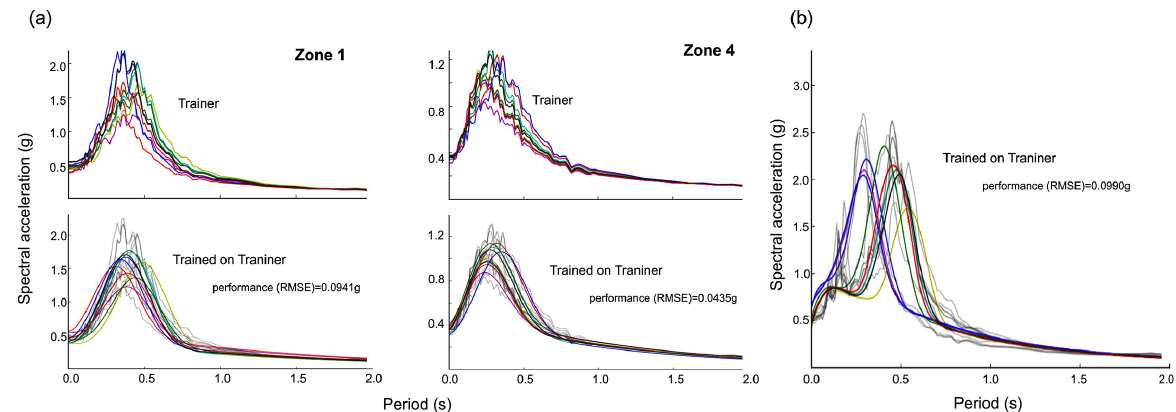
Figure 7. Performance of Emul-spectra: (a) stratigraphic seismic response with a damping of 0.05 regarding some trainer V S – h profiles of the SRS (all graphics are reported in the Supplement). The resulting performance defined by RMSE (g) are zone 1 = 0.0941; zone 2 = 0.0862; zone 3 = 0.0544; zone 4 = 0.0435; zone 5 = 0.0370; zone 6 (non rigid rock in outcropping) = 0.0032; zone 7 (rigid rock in outcropping) = 0.0045; zone 8 = 0.0394 (b) example on stratigraphic seismic responses that show a large spectral variability; the trainer spectra are obtained by the notable increasing of the top-layer thicknesses in the zone 1